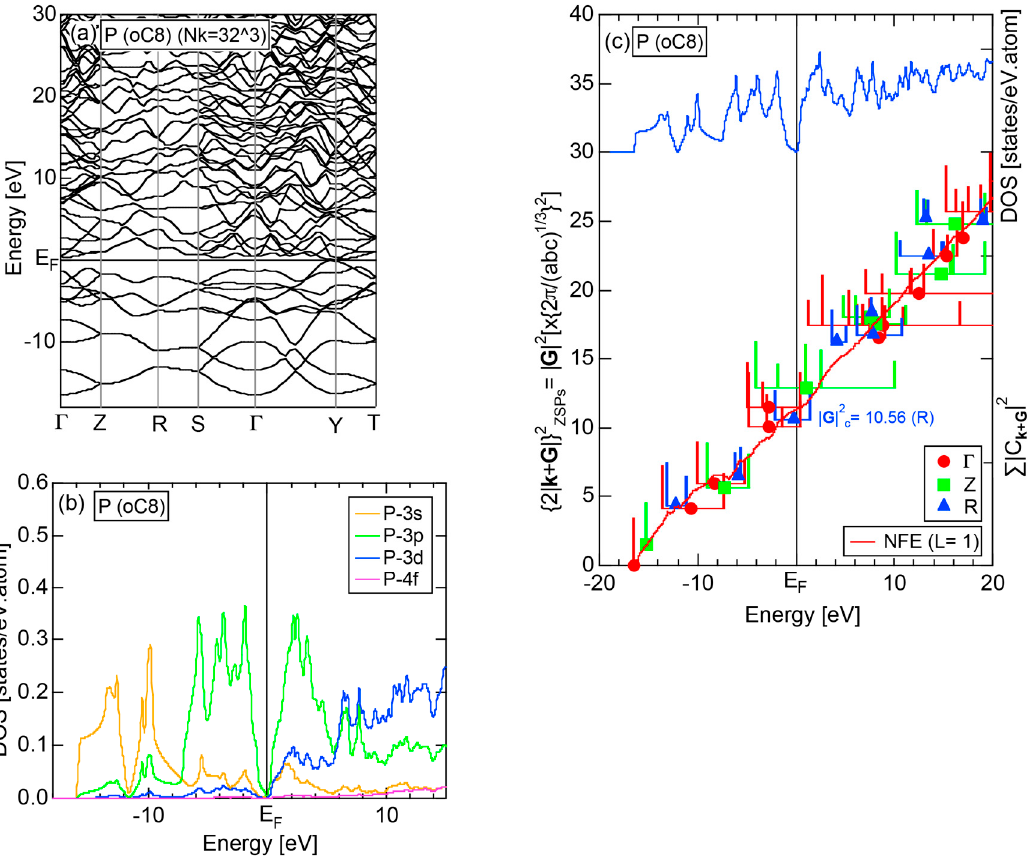
Figure 12. ( a ) Dispersion relations; ( b ) partial DOSs and ( c ) FLAPW-Fourier spectra at symmetry points Γ , Z and R of the Brillouin zone for the base-centered orthorhombic lattice for P (oC8) [11]. The total-DOS is incorporated in ( c ).